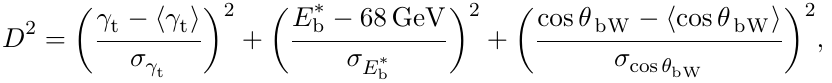
lepton, jets and top-quark candidate, as de(cid:12)ned above, e(cid:14)ciently reduce the number